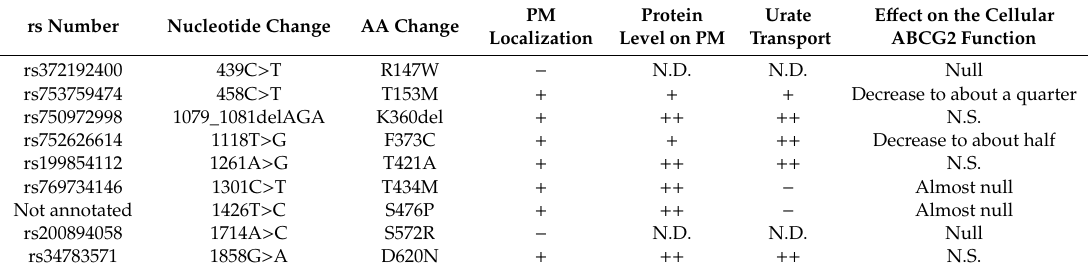
Table 3. Summary of the e ff ects of each mutation on ABCG2 protein and its